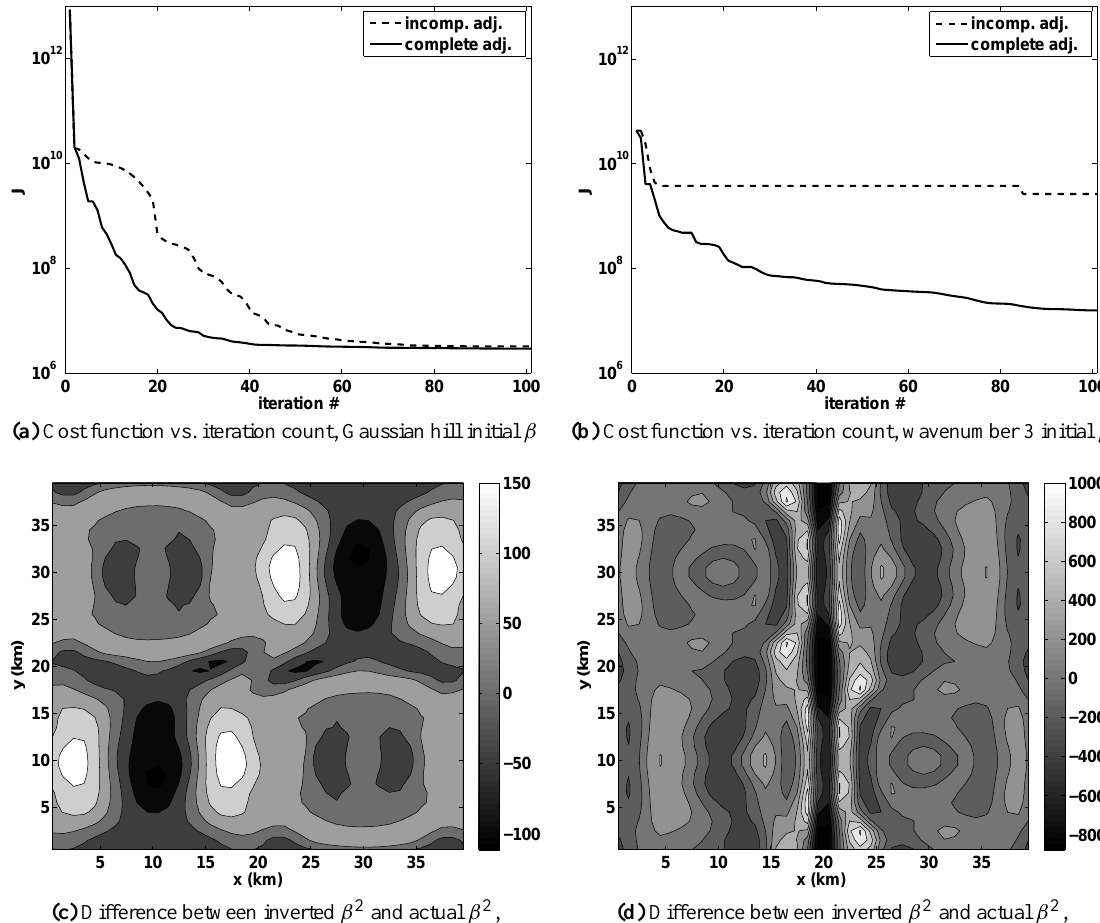
Fig. 4. Results of inversion in doubly-periodic domain, L x = 40km. “Observed” surface velocities are from results of ISMIP-HOM 3-D experiments. In the left column, the initial guess for β is a Gaussian hill in the middle of the domain (Eq. 20). In the right column, the initial guess is a wavenumber 3 variation in the along-flow direction (Eq.